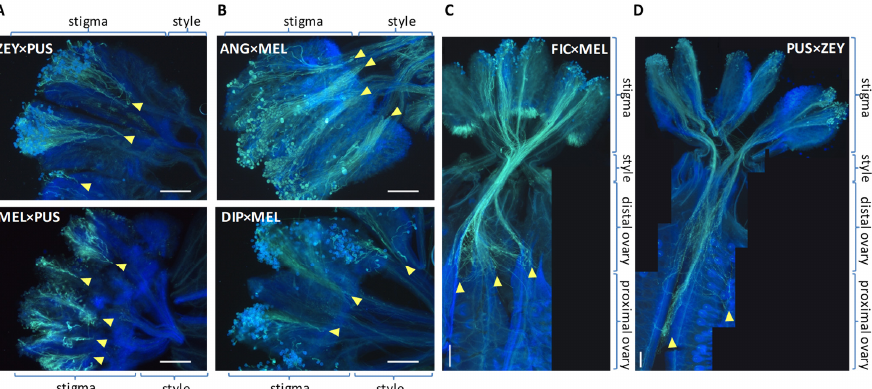
Figure 2. Pollen tube arrest in Cucumis interspecific crosses 24 h post-pollination. ( A ) Pollen tubes arrest before the stigma half, ( B ) at the late stigma or the style, ( C ) at the distal ovary, and ( D ) at the proximal ovary. Pictures correspond to the following crosses: ( A ) ZEY × PUS and MEL × PUS, ( B ) ANG × MEL and DIP × MEL, ( C ) FIC × MEL and ( D ) PUS × ZEY. Yellow arrowheads indicate sites of pollen tube arrest. Scale bars correspond to 500 µm.